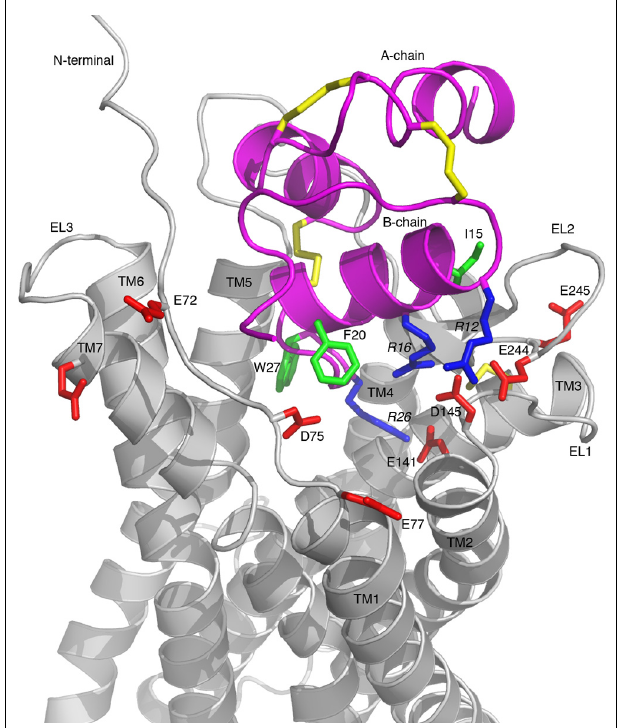
FIGURE 5 | Model of the RXFP3-H3 relaxin complex. H3 relaxin is shown in pink and RXFP3 in gray. All Asp/Glu residues in RXFP3 mutated during this study are shown in red and labeled with residue numbers. Key Arg and hydrophobic residues in H3 relaxin involved in the receptor binding are highlighted in blue and green, respectively, and labeled with residue numbers. Key features are the electrostatic interactions between the positively charged R12, R16, and R26 of H3 relaxin and the negatively charged E244, D145, and E141 of RXFP3,